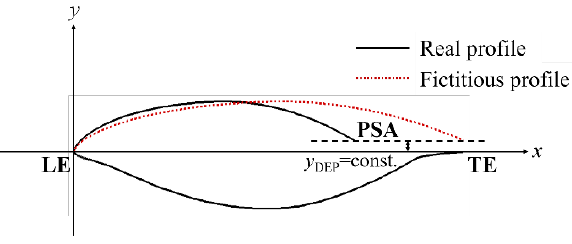
Figure 5 . Generation of the sectional fictitious airfoil.